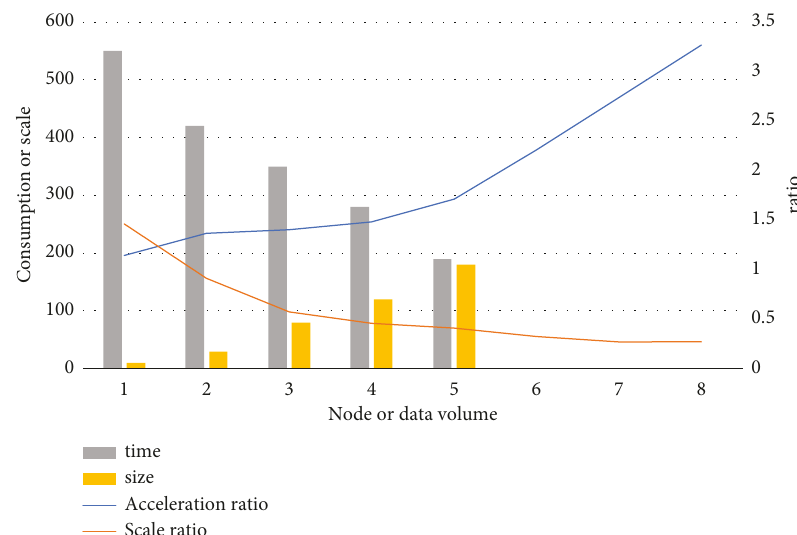
Figure 11: Acceleration ratio and scale